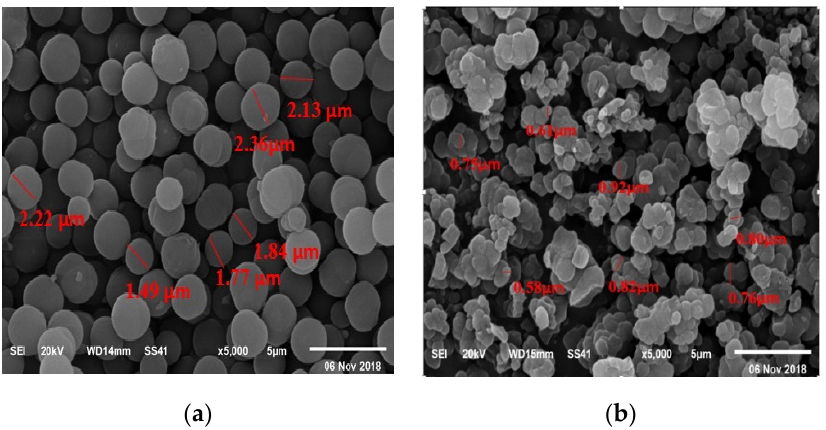
Figure 3. SEM images of ( a ) NIP and ( b ) washed MIP beads.